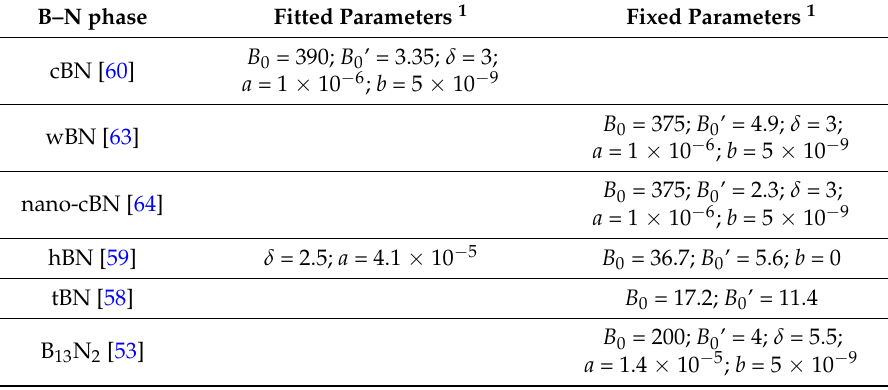
Table 1. Parameters of the p-V-T equations of state of BN polymorphs and